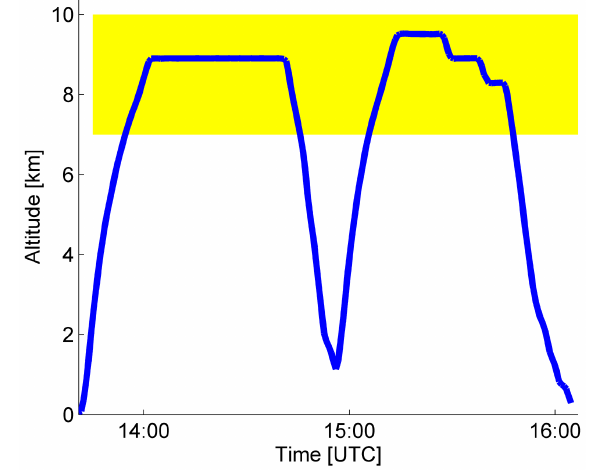
Fig. 4. A typical profile of a HOOVER2 flight. Coloured area high- lights the upper